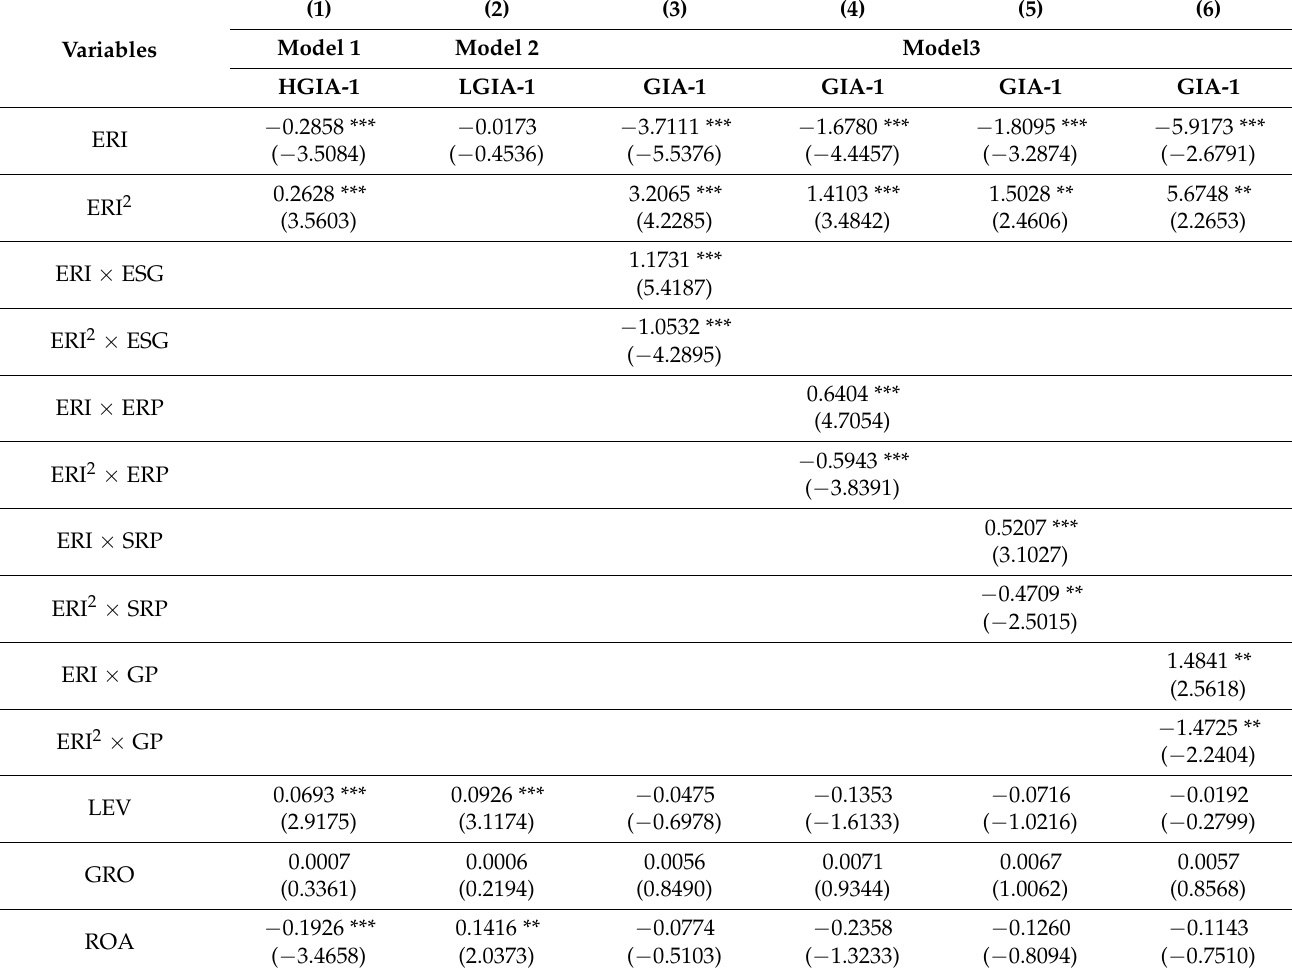
Table 9. Robustness Test